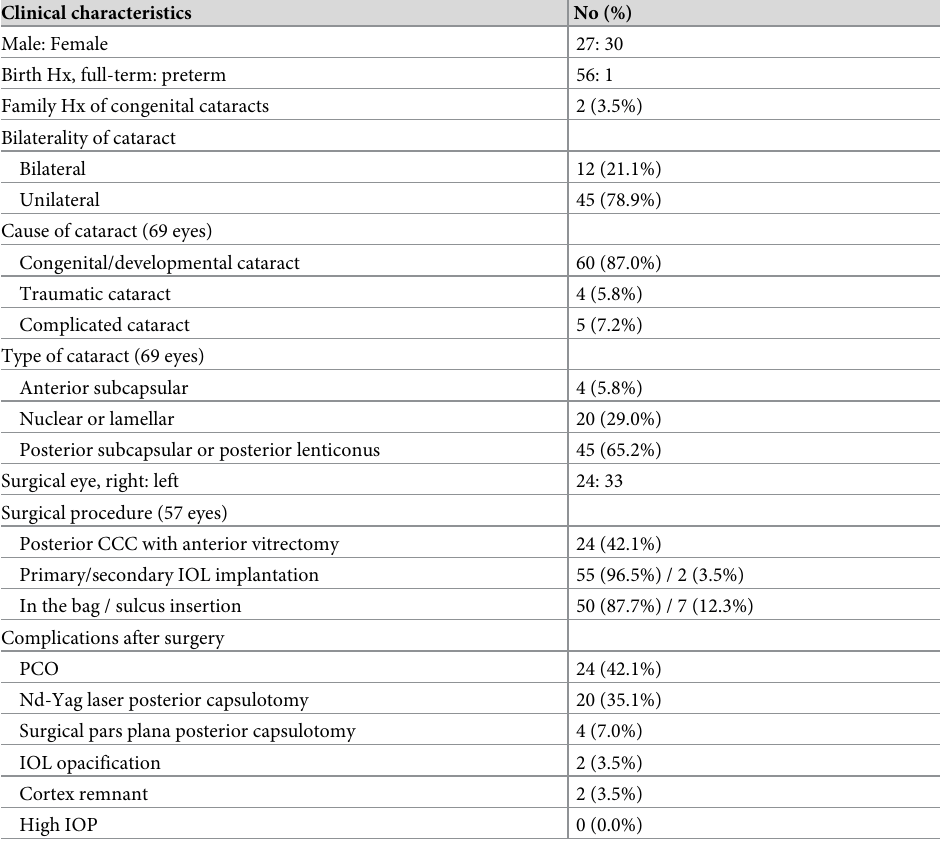
Table 1. Clinical characteristics of 57 children who underwent unilateral cataract surgery. Clinical